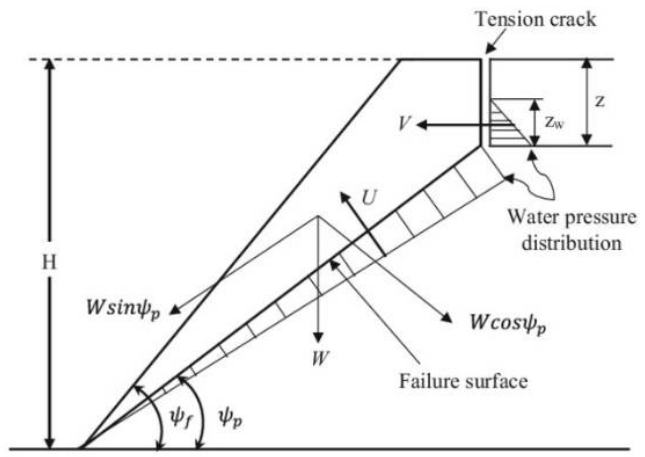
Figure 11. Effects of water pressure in a crack (Adapted from [81]).